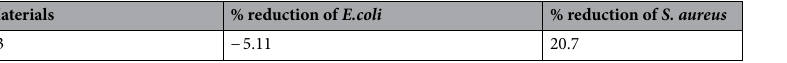
Table 3. The percent reduction of E. coli bacteria and S. aureus bacteria of the cellulose hydrogel with the weight ratios of cellulose and borax of 1 to 3.